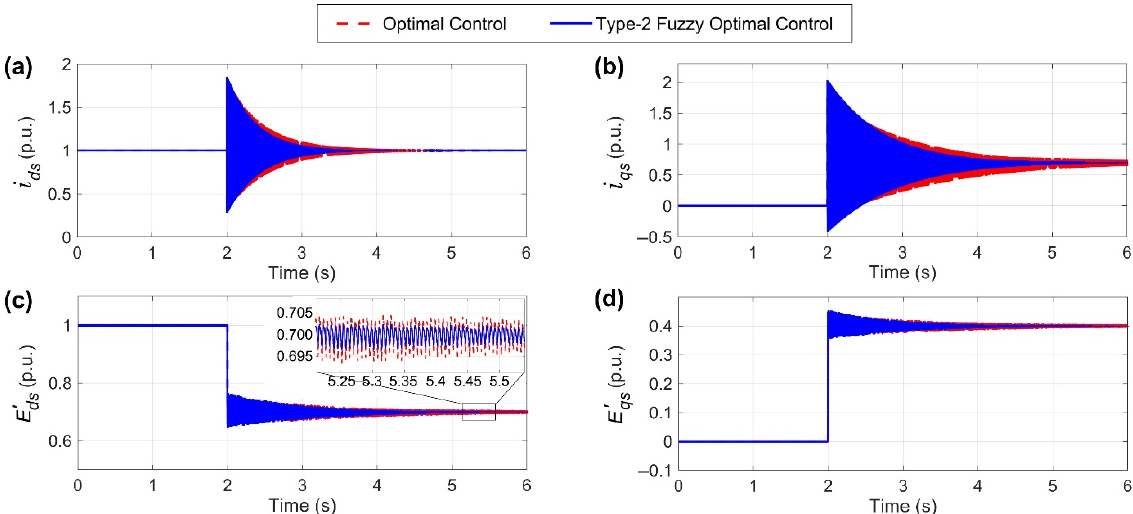
Figure 4. The shapes of ( a – d ) are related to the stator current signals i ds ( t ) and i qs ( t ) and their transient voltages 𝐸 (cid:3031)(cid:3046)(cid:4593) (𝑡) , and 𝐸 (cid:3044)(cid:3046)(cid:4593) (𝑡) , respectively. Note that “p.u.” means per unit.